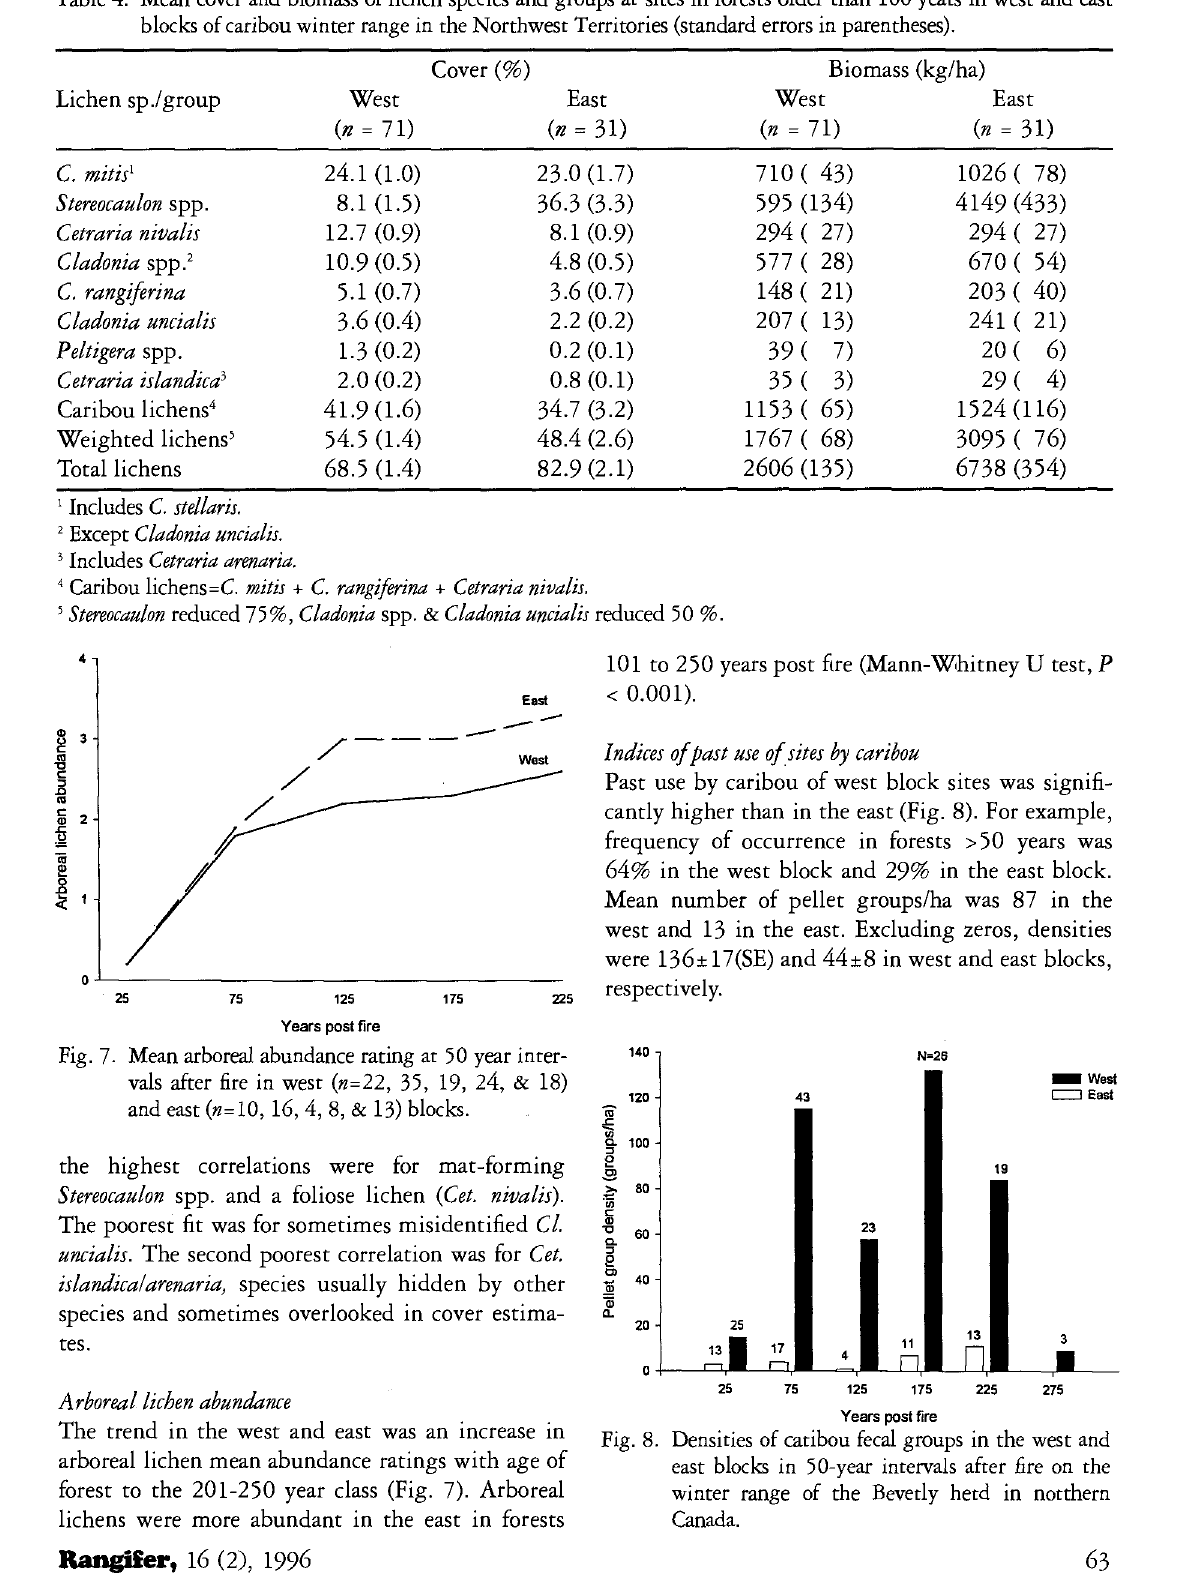
Table 4. Mean cover and biomass of lichen species and groups at sites in forests older than 100 yeats in west and east blocks of caribou winter range in the Northwest Territories (standard errors in parentheses).